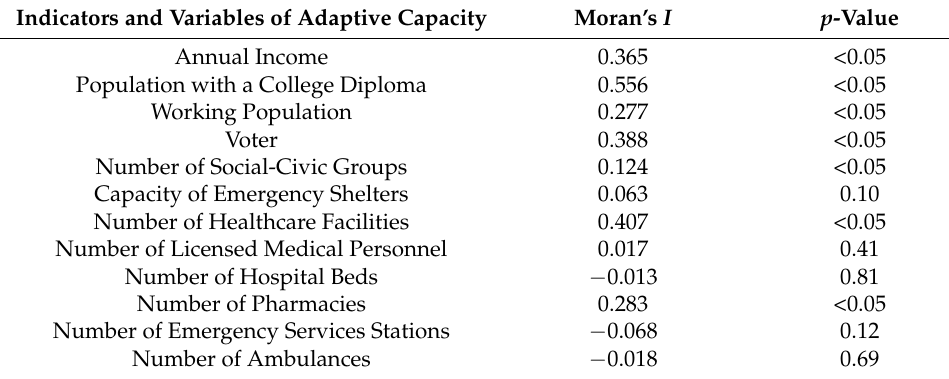
Table 2. Indicators and variables of adaptive